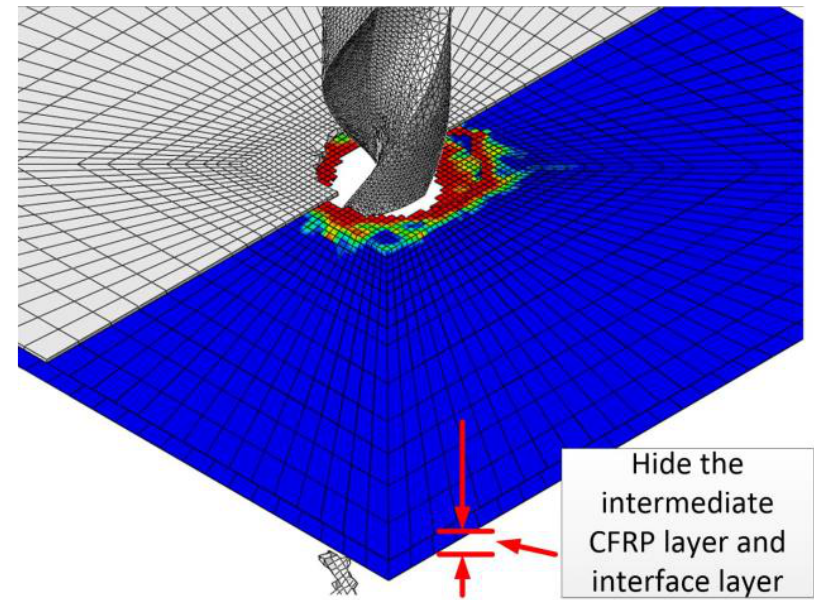
Figure 3. Comprehensive diagram of Figure 4.